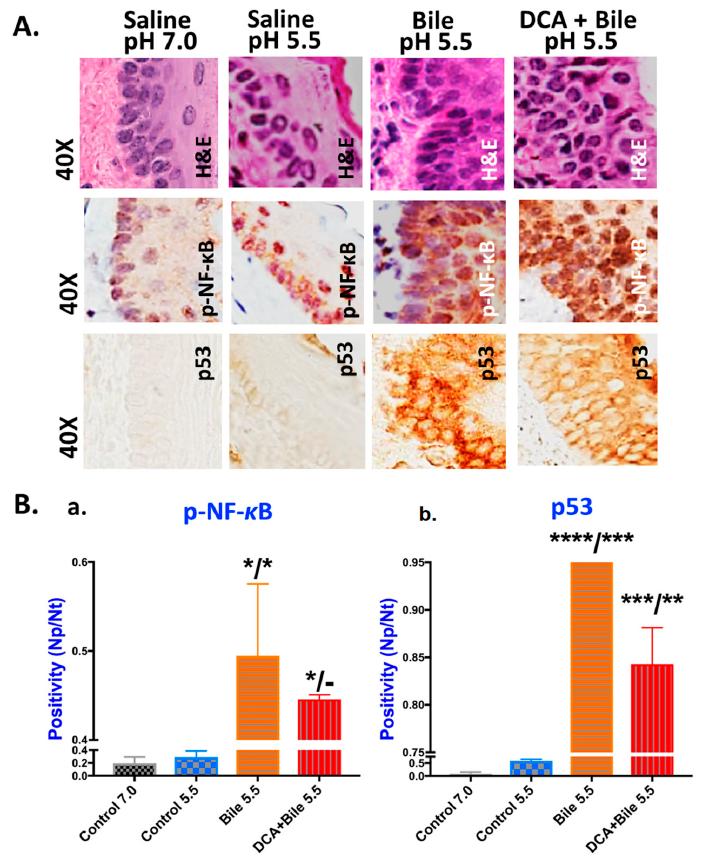
Figure 3. Weakly acidic bile-induced NF- κ B activation and increased expression of p53 in murine hypopharyngeal mucosa (HM) after 15 weeks of exposure. ( A ). Immunohistochemical analysis (IHC), using chromogenic staining, was performed for p-NF- κ B (p65 S536) (brown) and p53 (brown). ( B ). Graphs created by GraphPad Prism 7.0 indicate a statistically significant difference of ( a ) nu- clear positivity for p-NF- κ B and ( b ) cytoplasmic positivity for p53 (by Image Scope software) be- tween weakly acidic bile with or without DCA vs. controls (* p < 0.01; ** p < 0.001; *** p < 0.0001; **** p < 0.00001; by t -test; multiple comparisons by Holm-Sidak; GraphPad Prism